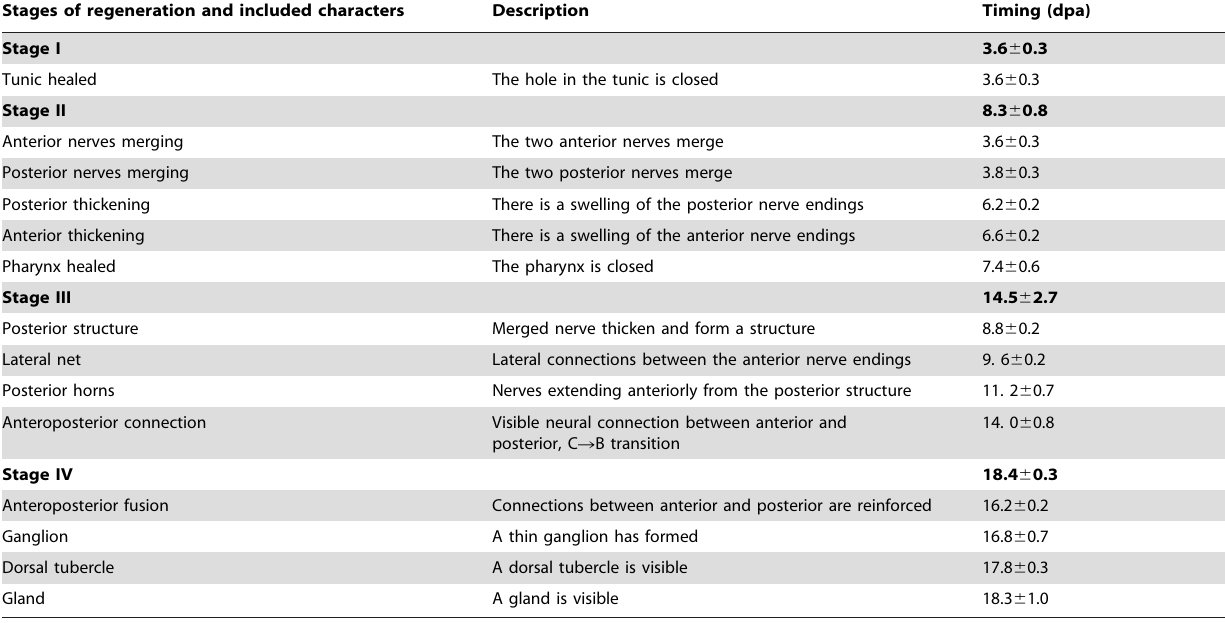
Stages of regeneration and included